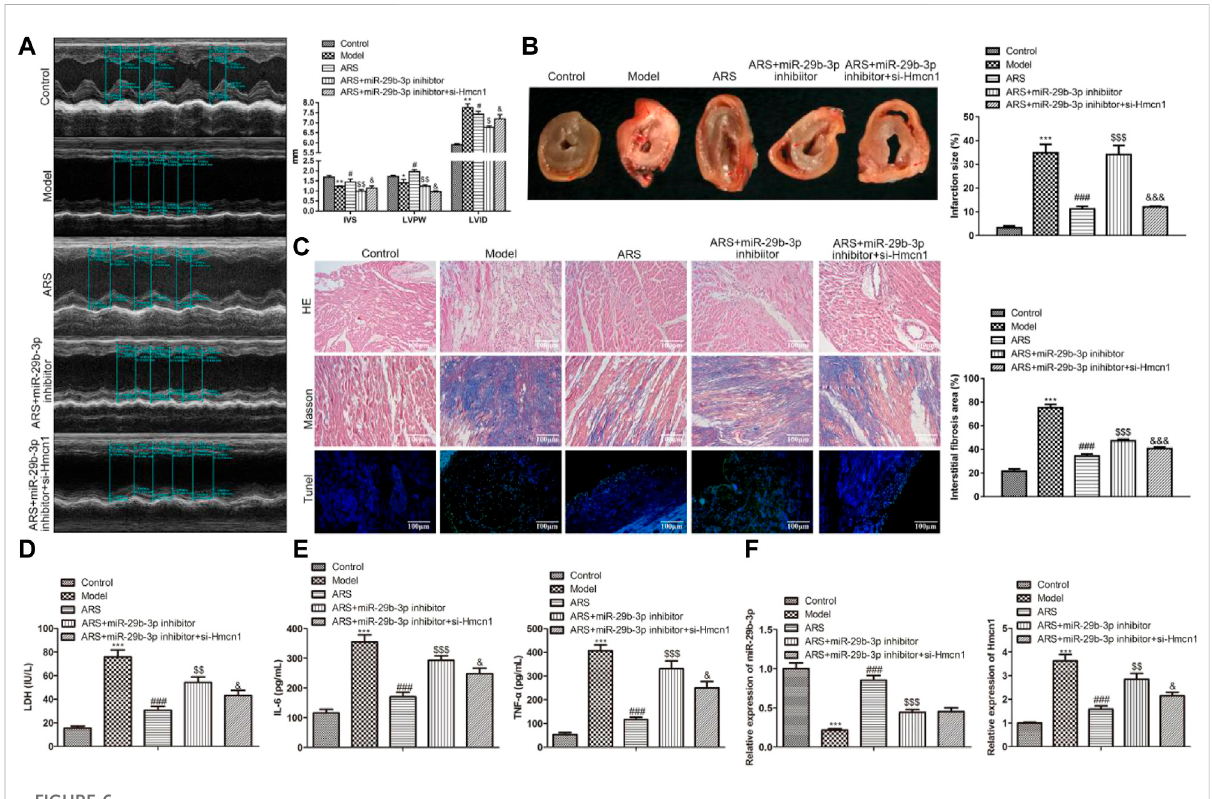
FIGURE 6 ARS suppresses myocardial I/R injury through regulating miR-29b-3p/HMCN1 in